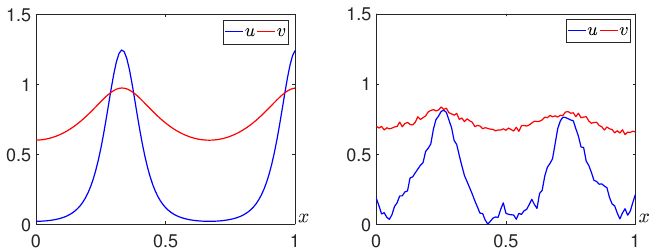
Figure 5. Stochastic transition 1.5 ↑→ 2 ↑ in Systems (1), (2) with a = d = e = 0.5, b = c = 1, D u = 5 × 10 − 4 , D v = 0.02 for noise intensity ε = 0.1: initial state ( left ) and final state ( right ).